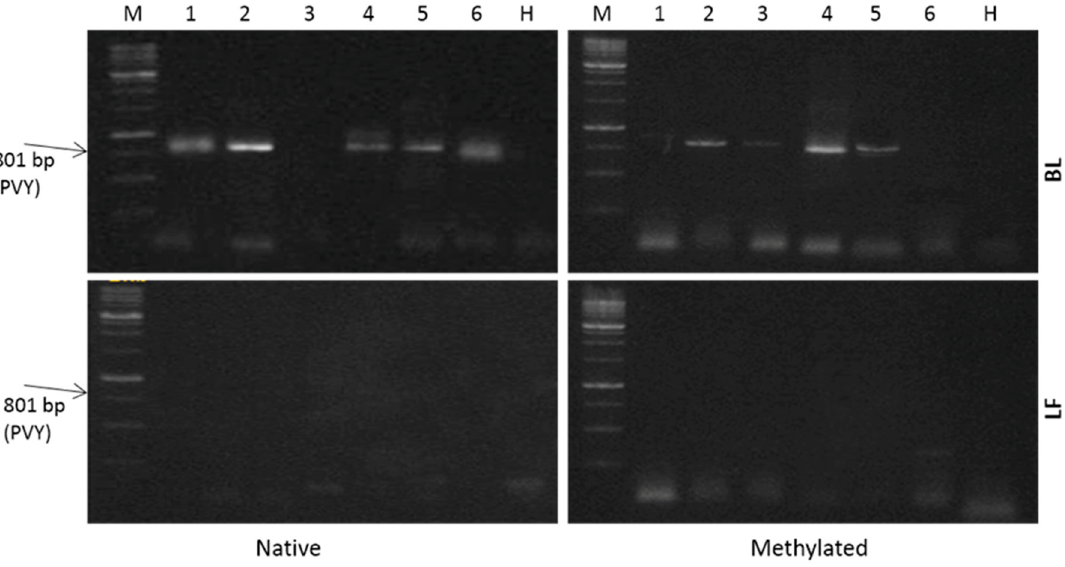
Figure 4. Detection of PVY in potato leaves using one step RT-PCR guided by Verso TM one step RT- PCR kit (Thermo scientific) and visualized by gel electrophoresis in the leaves of potato plants cultivated under open field conditions receiving a single application of 500 µ g mL − 1 of LF and BL, or their methylated forms, (MLF and BLM, respectively). Six representative plant samples out of a total of 15 plants/treatment were used in this analysis.